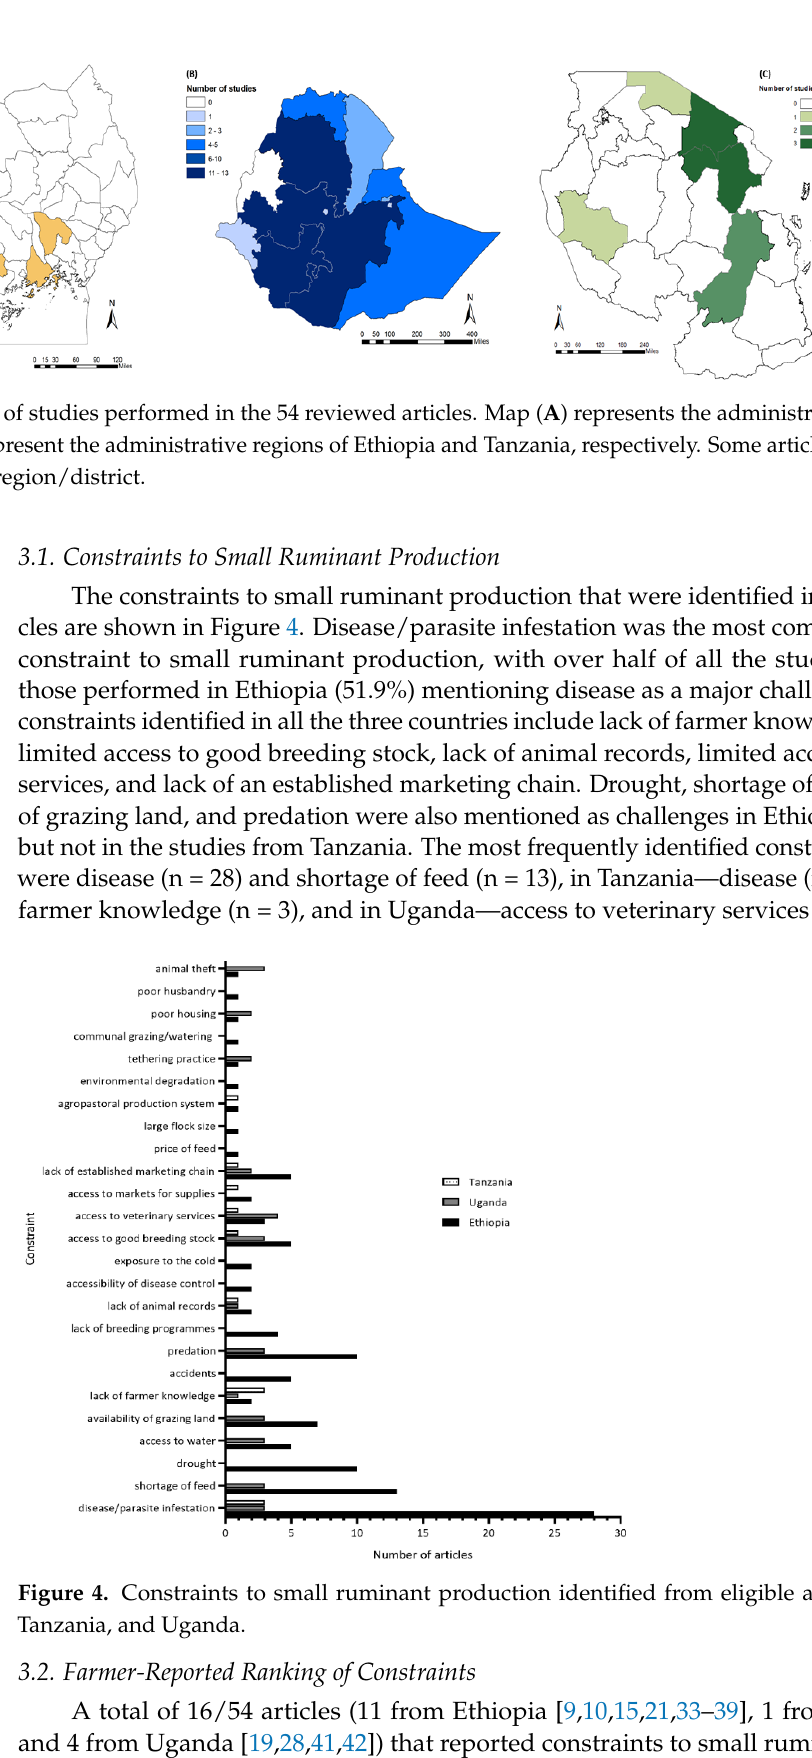
Figure 2. Number of articles and the year of publication.